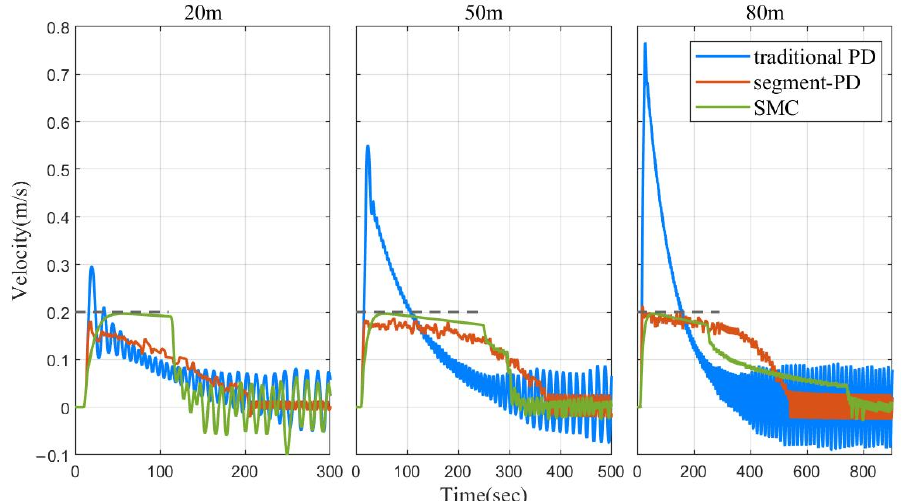
Figure 5. Speed comparison of the three depth control methods in the processes of float diving and depth depth control.